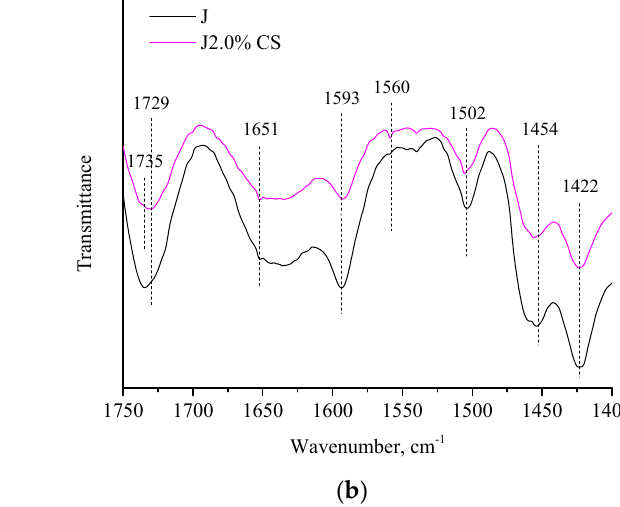
Table 1. Wavenumber of IR absorption bands and their interpretation according to the literature [19–25].